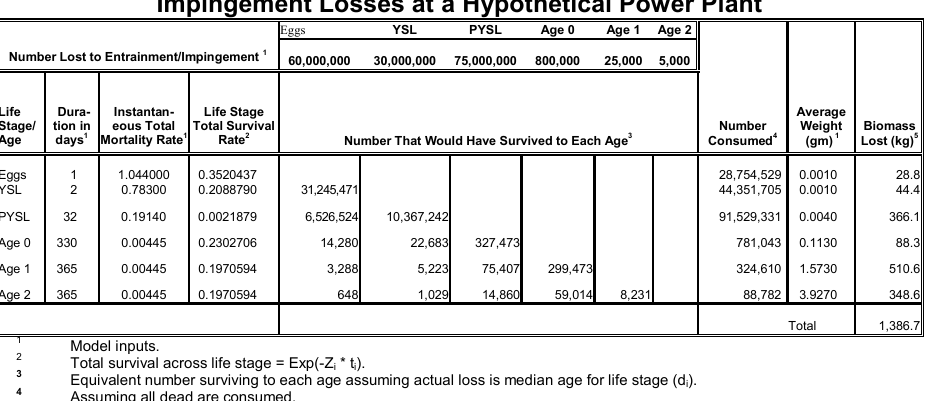
Example of the BLM for Bay Anchovy Based n Entrainment and Impingement Losses at a Hypothetical Power